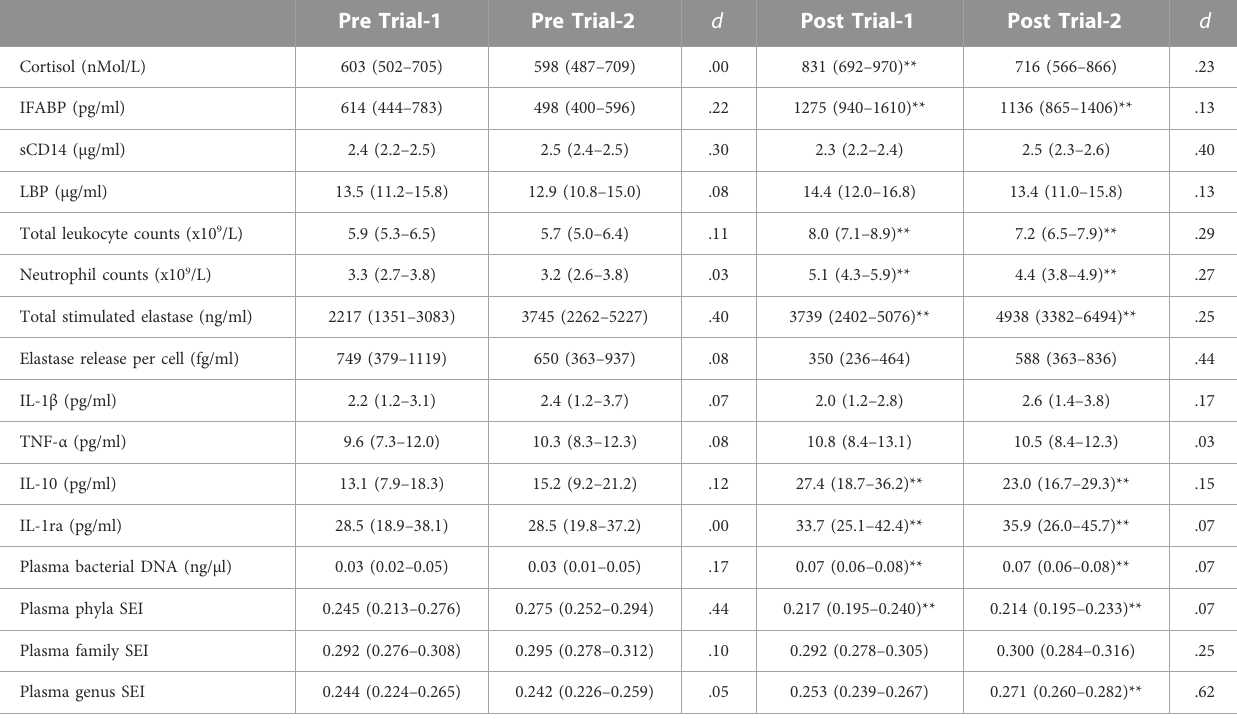
TABLE 2 Pre- and post-exercise exercise-induced gastrointestinal syndrome (EIGS) biomarkers in response to 2 h high intensity interval exercise in temperate ambient conditions performed on two separate occasions. Pre